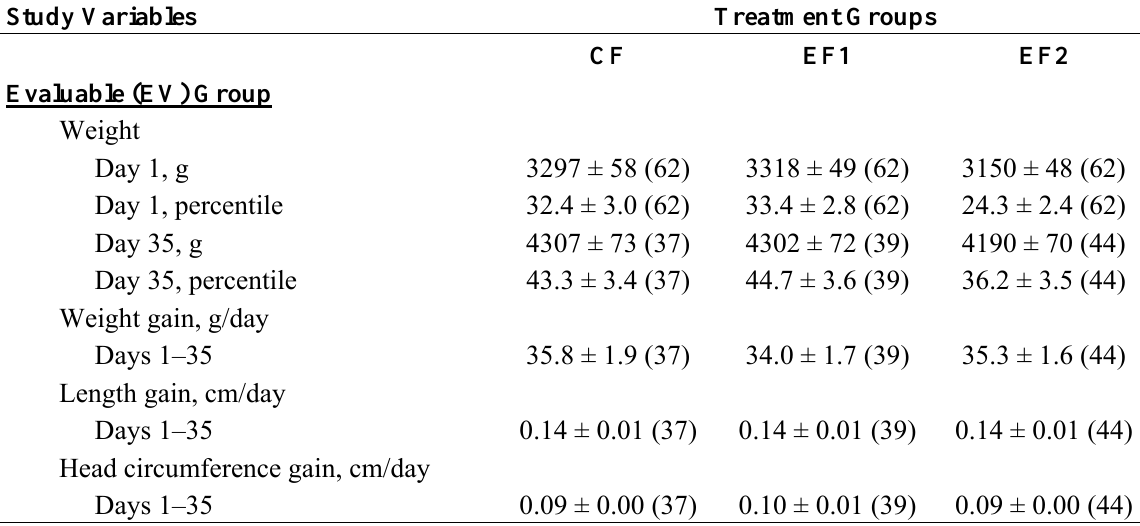
Table 3. Anthropometric values for study subjects